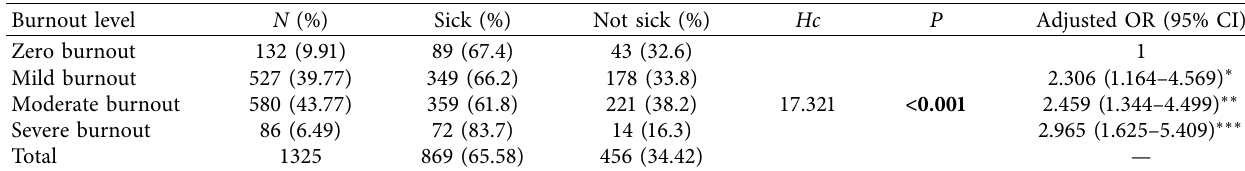
Table 3: Prevalence of WMSDs in different levels of burnout ( N �